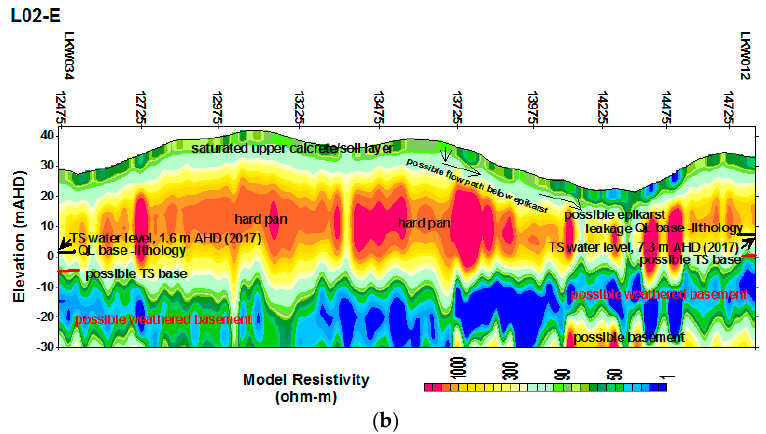
Figure 10. TEM sections for LO2; ( a ) LO2-D (from ULE092 to LKW034); ( b ) LO2-E (from LKW034 to LKW012).